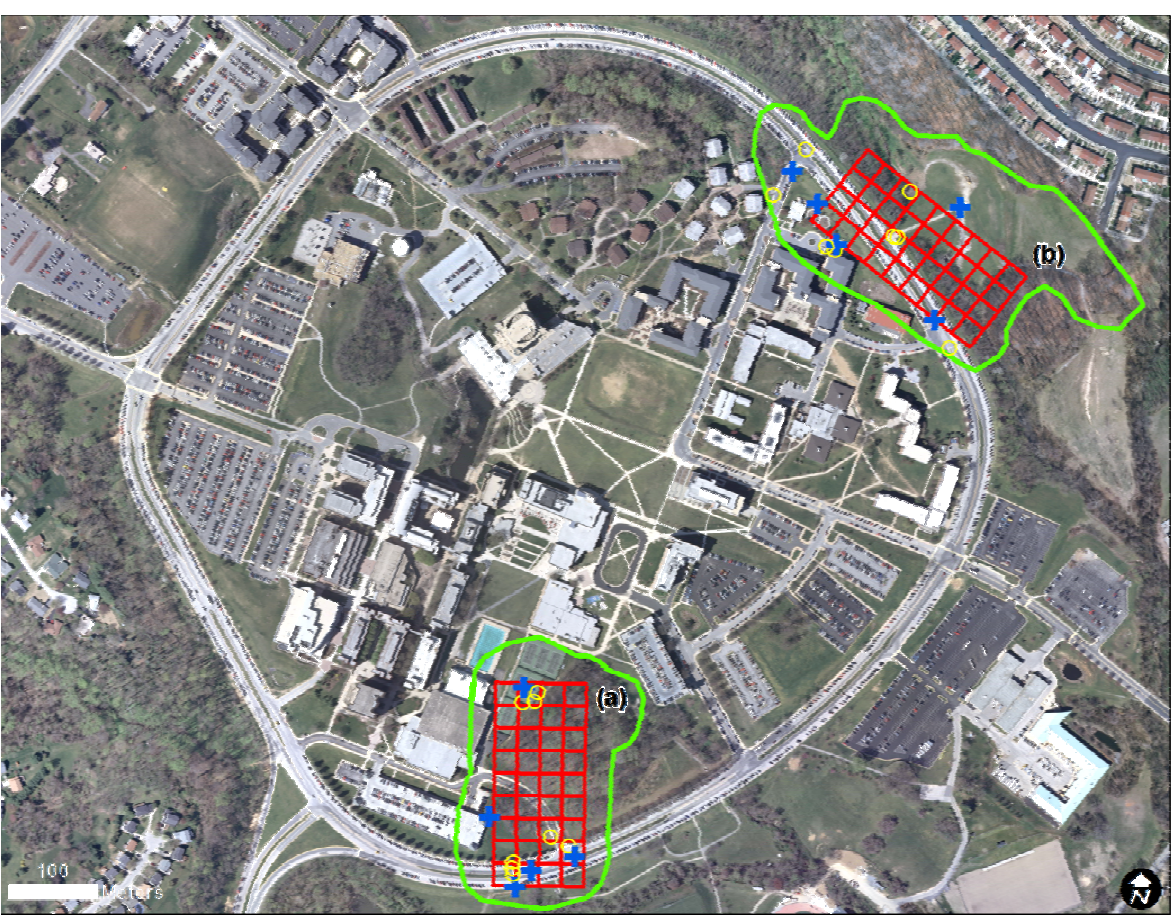
Figure 1. The Knoll ( a ) and Herbert Run ( b ) test sites on the campus of the University of Maryland Baltimore County. Sites and 25 m × 25 m subplots are outlined in red over 2008 leaf-off orthophotograph. Green lines delimit the approximate extent of kite aerial photograph acquisition at each site, blue crosses are GCPs used for geocorrection, and yellow circles are GCPs used in geocorrection accuracy